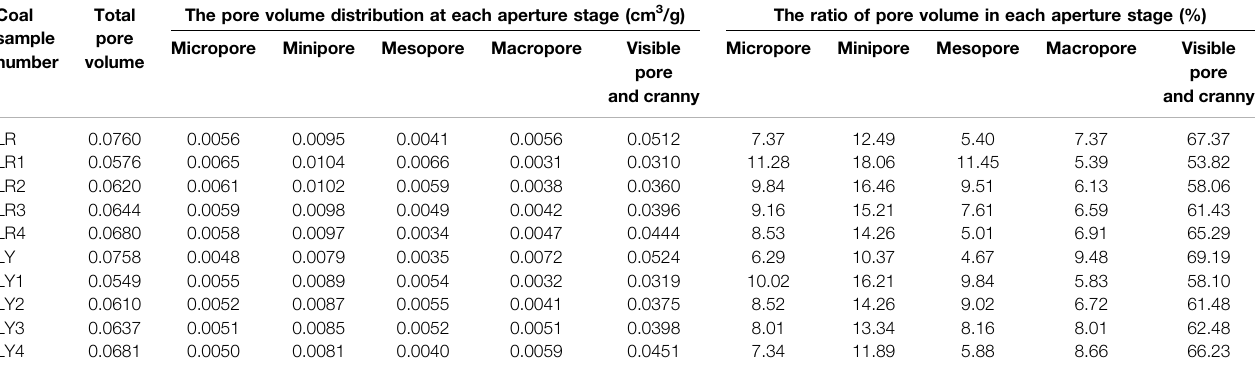
TABLE 3 | Pore volume distribution of coal samples with the mercury intrusion method. Coal Total sample pore number